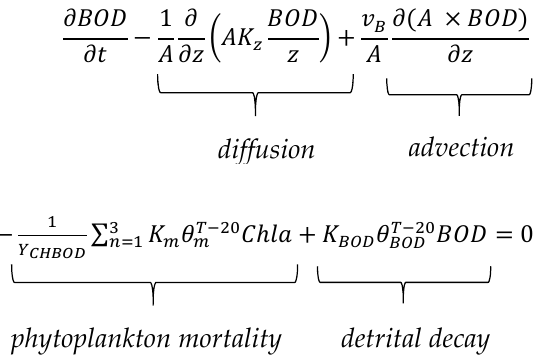
Figure 6. Schematic diagram of BOD cycle modeled by